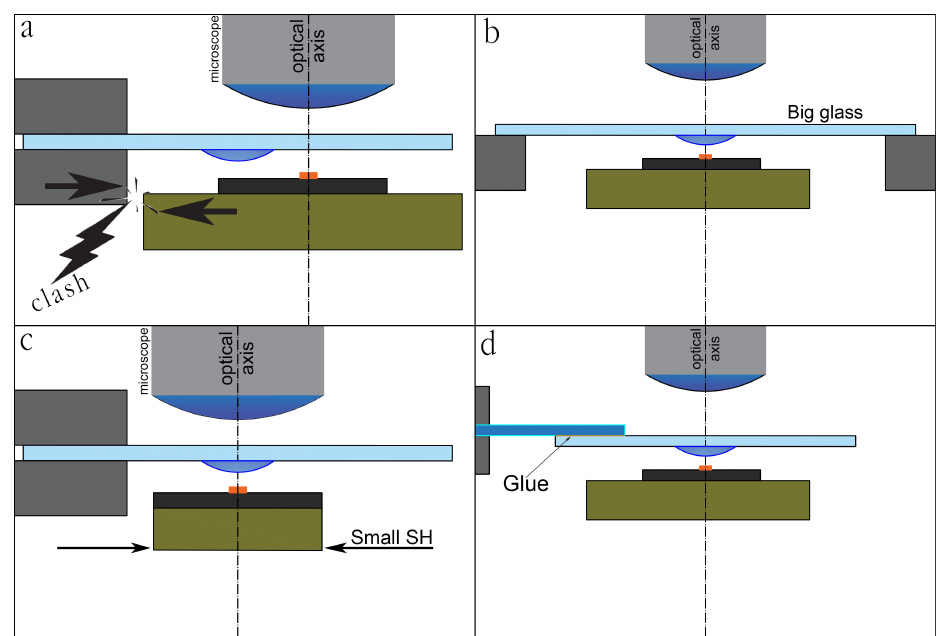
Figure 3. Problem of too small glass slide ( a ) and its possible solutions: ( b ) using large glass e.g., like in mask aligner; ( c ) making a small sample holder table; ( d ) gluing a glass slide or stamp to the end of the other